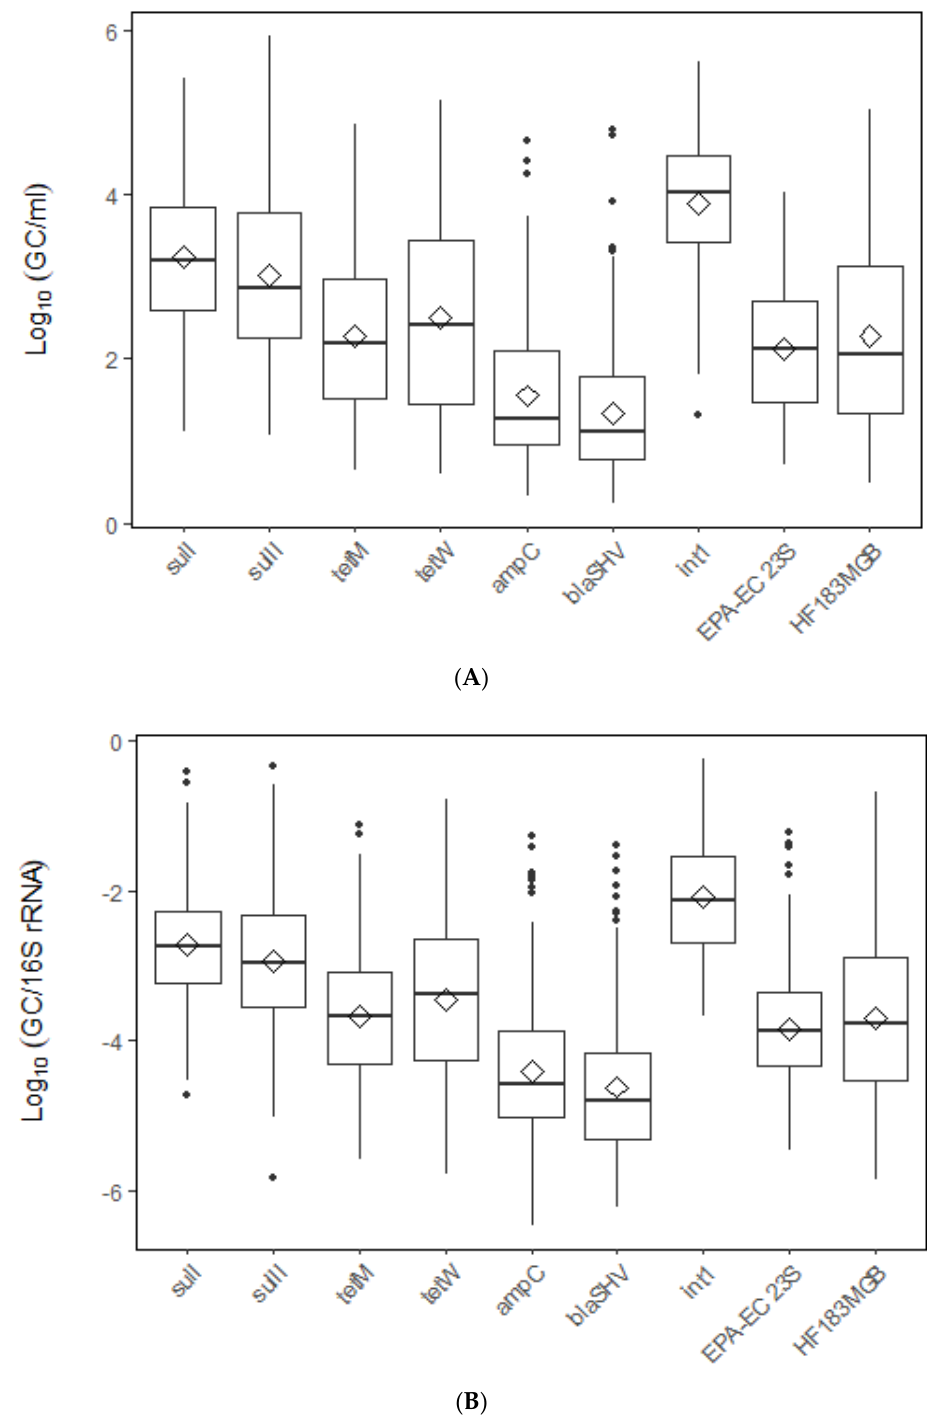
Figure 3. Concentration ( A ) and relative abundance ( B ) of ARGs, fecal markers, and int1 gene for the pooled dataset. Relative abundance was calculated as the concentration of ARGs normalized to the concentration of the 16S rRNA gene.